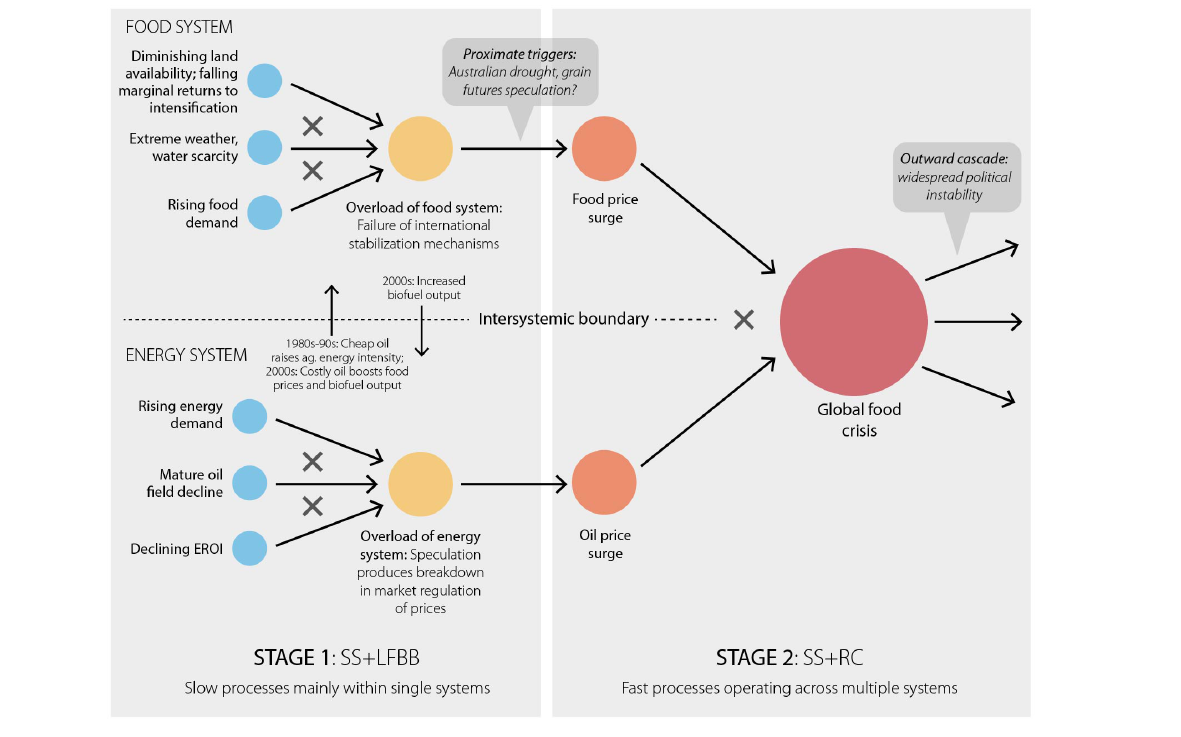
Fig. 3 . The 2008 food-energy crisis. SS = simultaneous stresses; LFBB = long fuse big bang; RC = ramifying